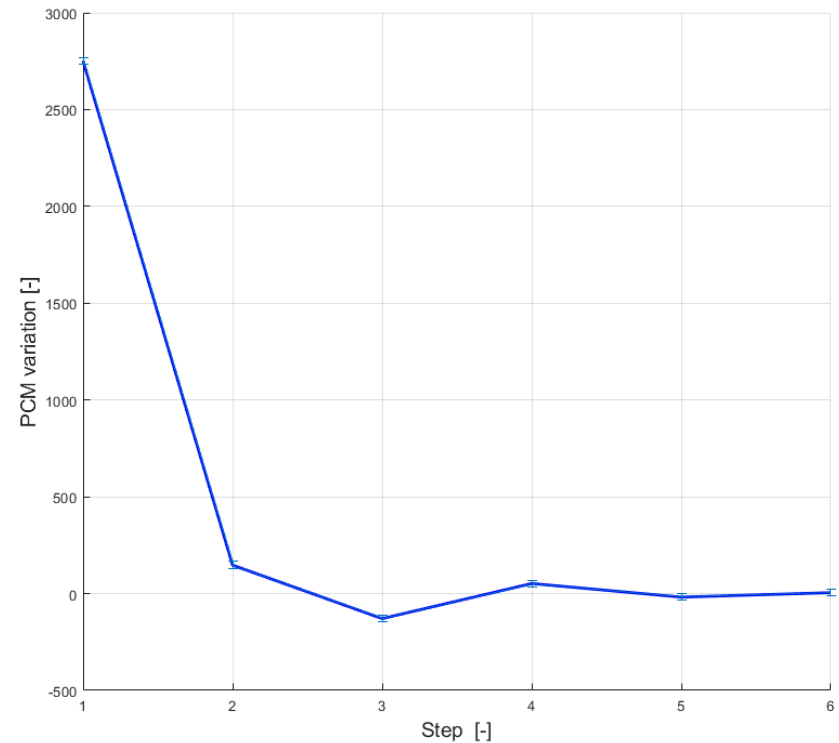
Figure 14. PCM variation per stage of iteration between Serpent/CTF stage.